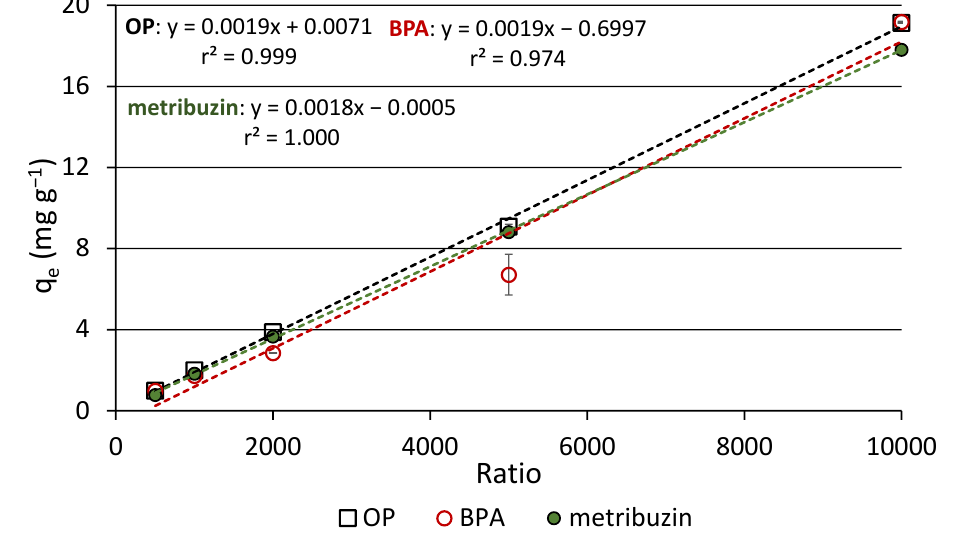
Figure 4. Effects of the solution/biochar ratio on the adsorption of the compounds at the equilibrium condition. Table 3. Amount of compound adsorbed (mg g − 1 ) as a function of the solution/biochar ratio adopted. One- way analysis of variance (ANOVA) and Duncan’s new multiple range test at p ≤ 0.01 (n = 3) were used for statistical treatment of data.